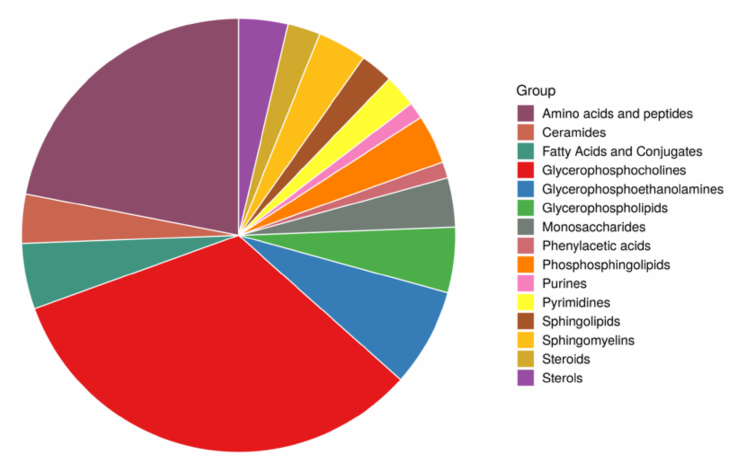
Figure 2. Metabolite classes with significantly different concentrations between patient groups.